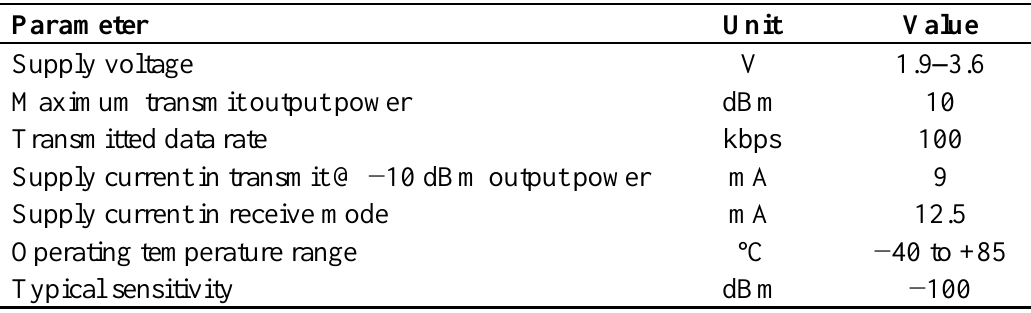
Table 2. nRF905 signal transceiver chip specifications